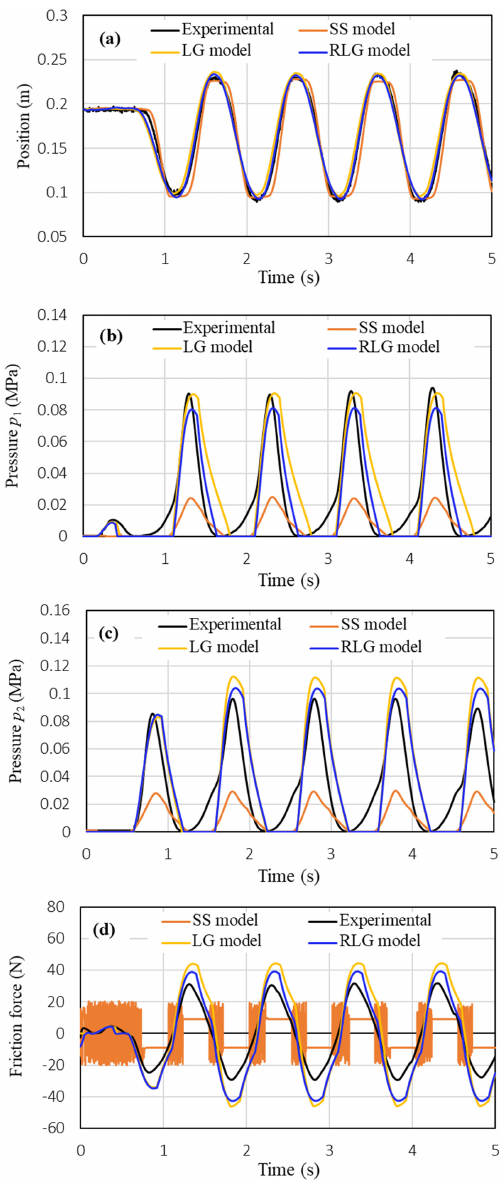
Figure 11. Comparison between measured characteristics of the piston position, pressures and friction force and those simulated using the three friction models: (a) piston position, (b) pressure p 1 , (c) pressure p 2 , (d) friction force ( M = 0 . 5kg, u 1 = 2 . 5 + 0 . 5sin(2 πf t )(V), u 2 = 2 . 5 − 0 . 4sin(2 πf t )(V), f = 0 . 2Hz).